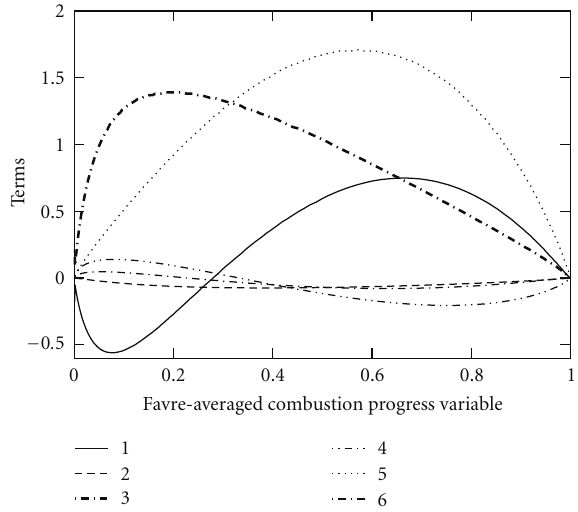
Figure 7: Term ( g 2 1 − Q )( z f − z ) 2 in (25) (1) and mean axial velocities calculated using (2) equation (14) and (3) equation (22) versus the Reynolds-averaged combustion progress variable. Results shown in bold and thin lines have been obtained for flames h4 and h6, respectively, investigated by Li et al. [17].